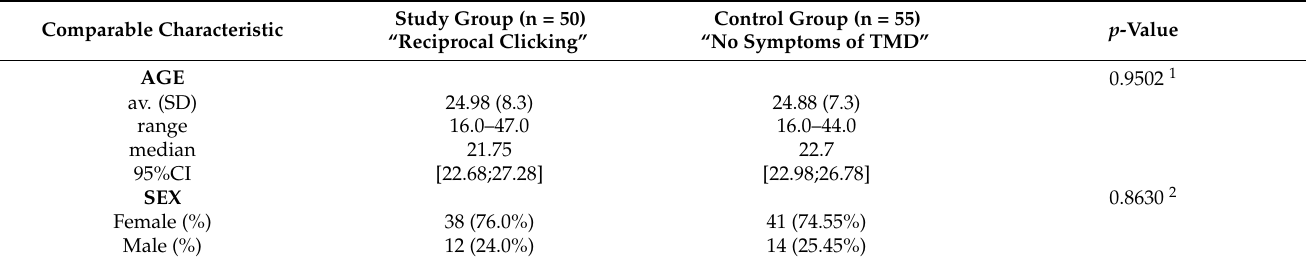
Table 4. Comparison of age and sex between the examined